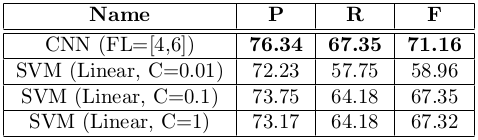
Table from the paper: Relation extraction from clinical texts using domain invariant convolutional neural network
Table text:
Name
P
R
F
CNN(FL=[4,6])
76.34
67.35
71.16
SVM(Linear,C=0.01)
72.23
57.75
58.96
SVM(Linear,C=0.1)
73.75
64.18
67.35
SVM(Linear,C=1)
73.17
64.18
67.32